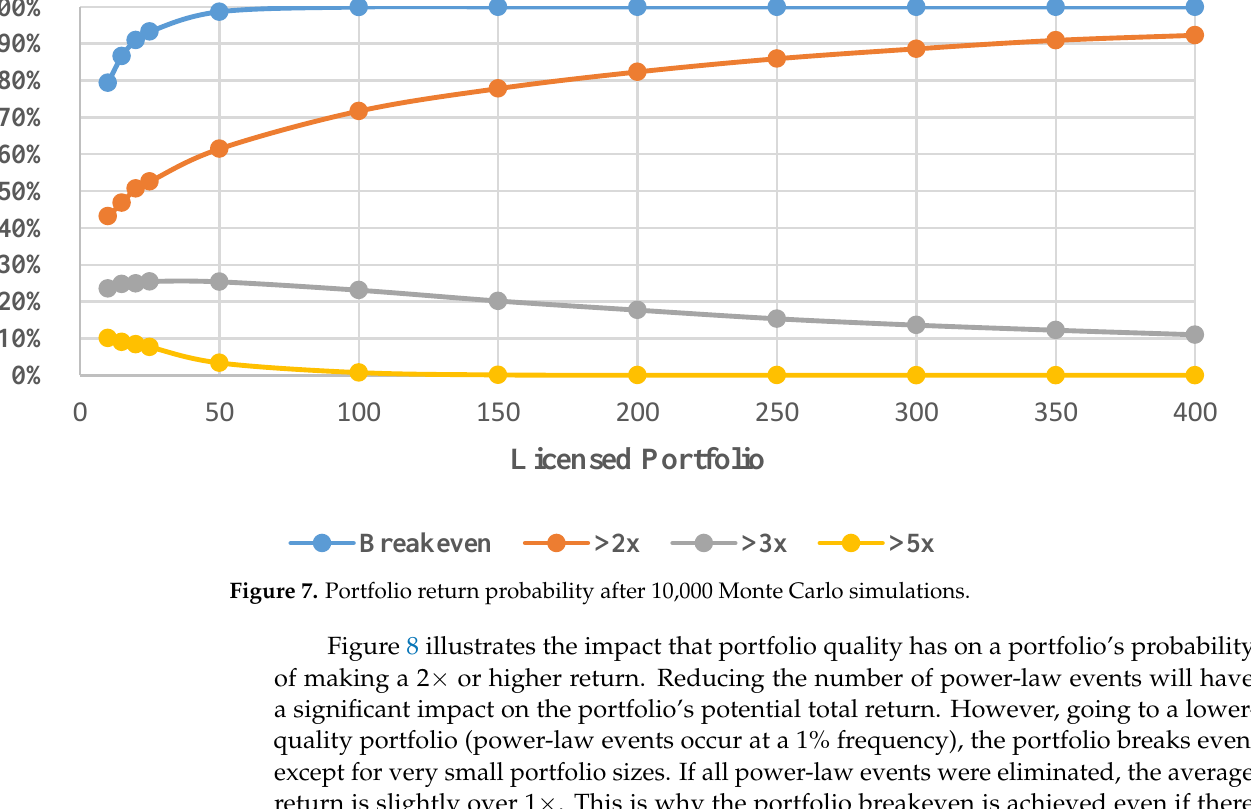
Figure 7 . Portfolio return probability after 10,000 Monte Carlo simulations.